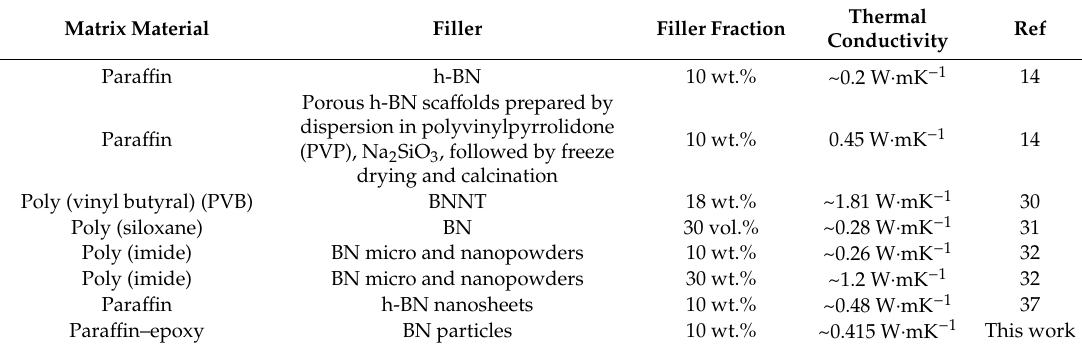
Table 2. Thermal conductivity comparison with other reports. h-BN: hexagonal boron nitride.